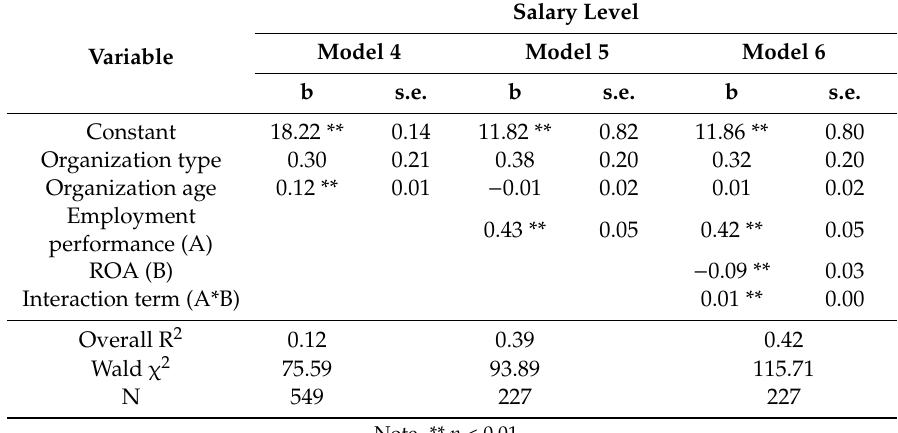
Table 4. Panel analysis: salary level, employment performance and return on assets (ROA).